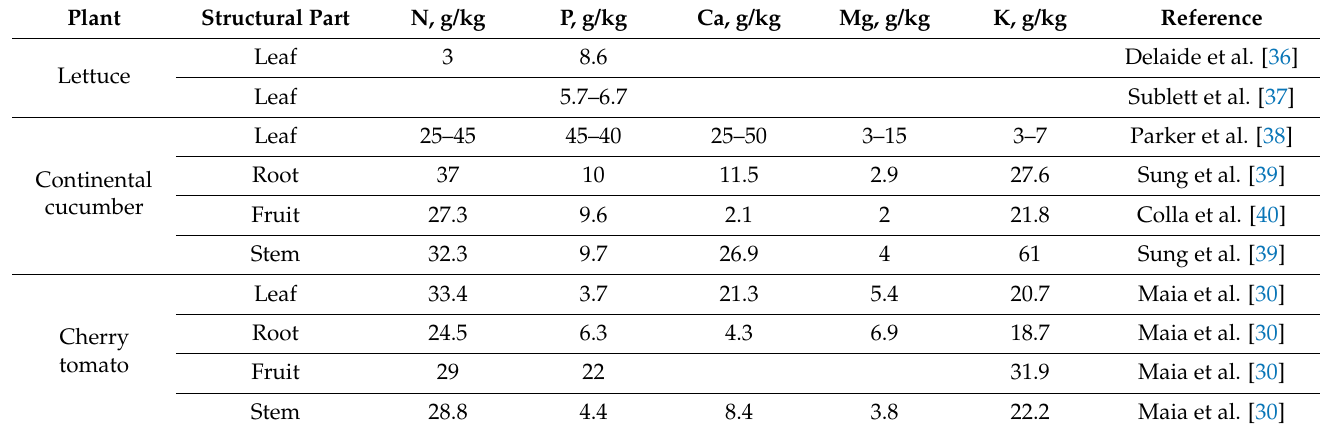
Table 1. Nutrient concentrations in different structural parts of the plant from